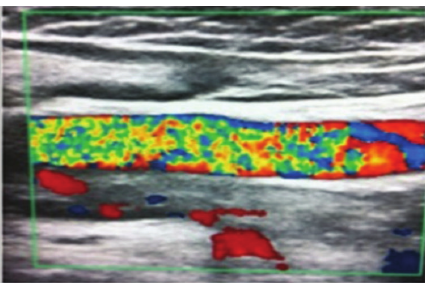
Figure 2: Doppler ultrasound revealed thrombosis in a main femo- ral vein, 95 × 79